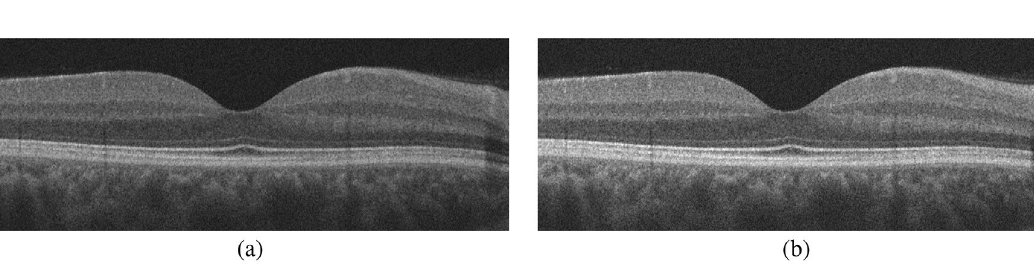
Figure 4. An illustrative example of the estimated CDF percentile feature of the 1st-order reflectivity for a normal and a DR case at the NPL layer.